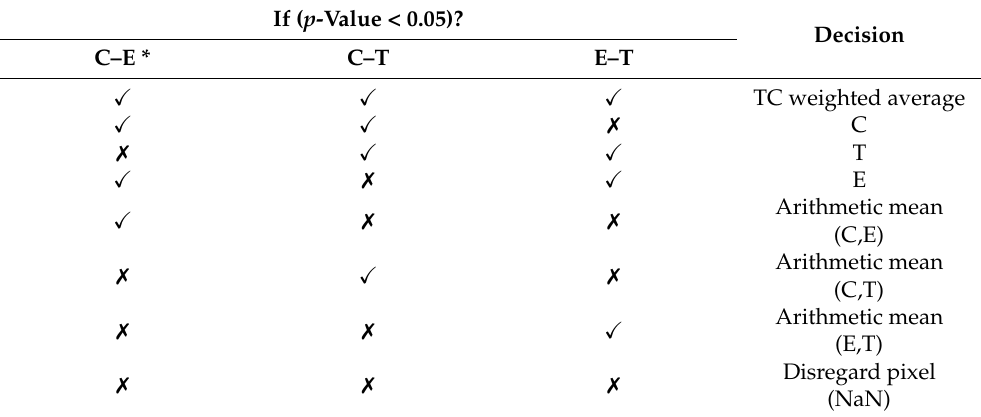
Table 1. Merging scheme based on Pearson correlation with a significance level of